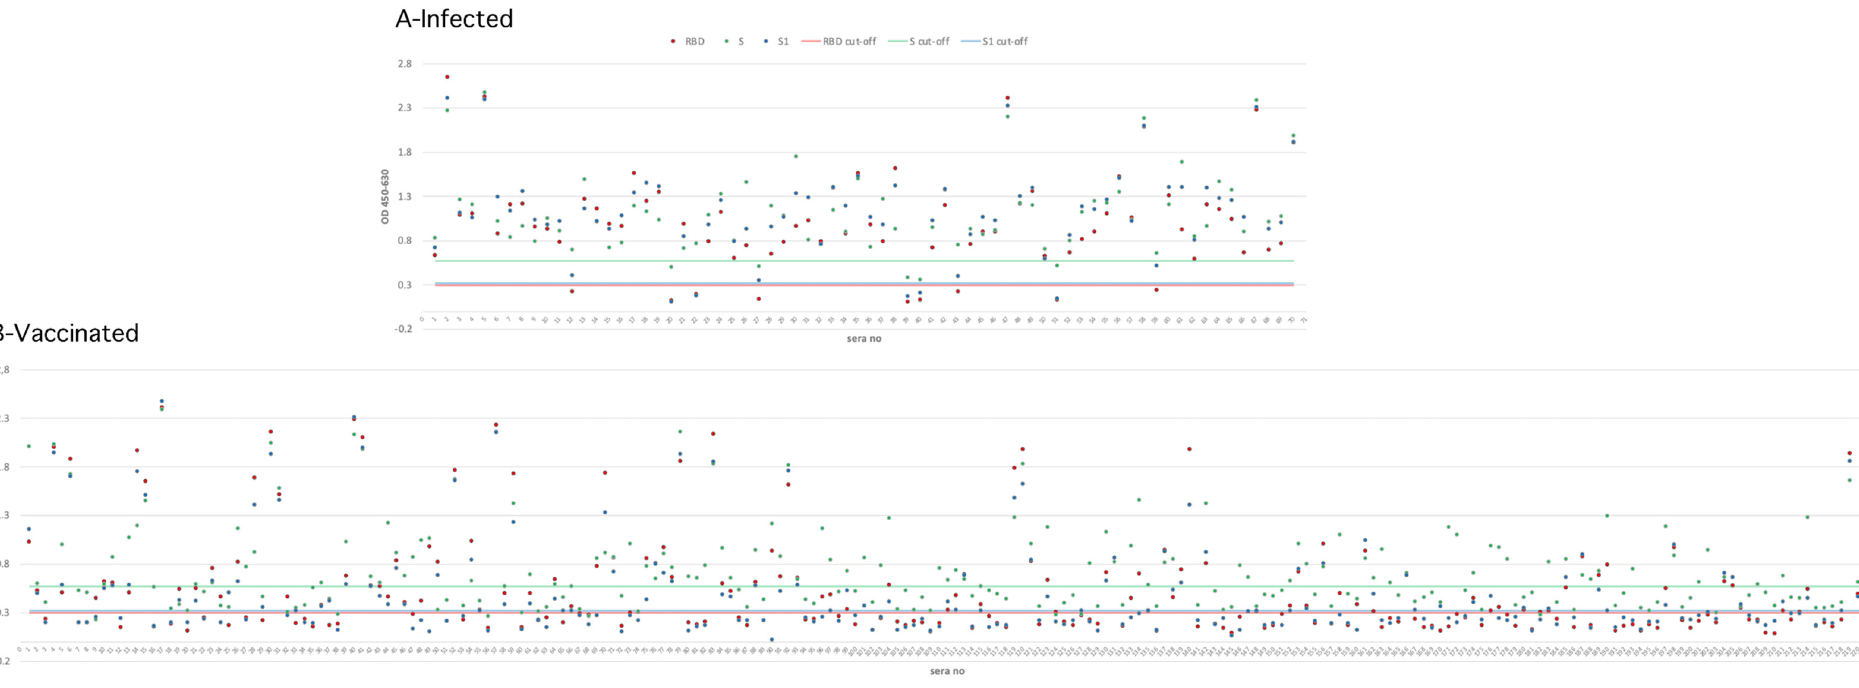
Figure 1. OD values of sera analyzed by the in-house S, S1 and RBD ELISAs. ( A ) Human sera infected with SARS-CoV-2; ( B ) Human sera vaccinated with SARS-CoV-2 inactivated vaccine.